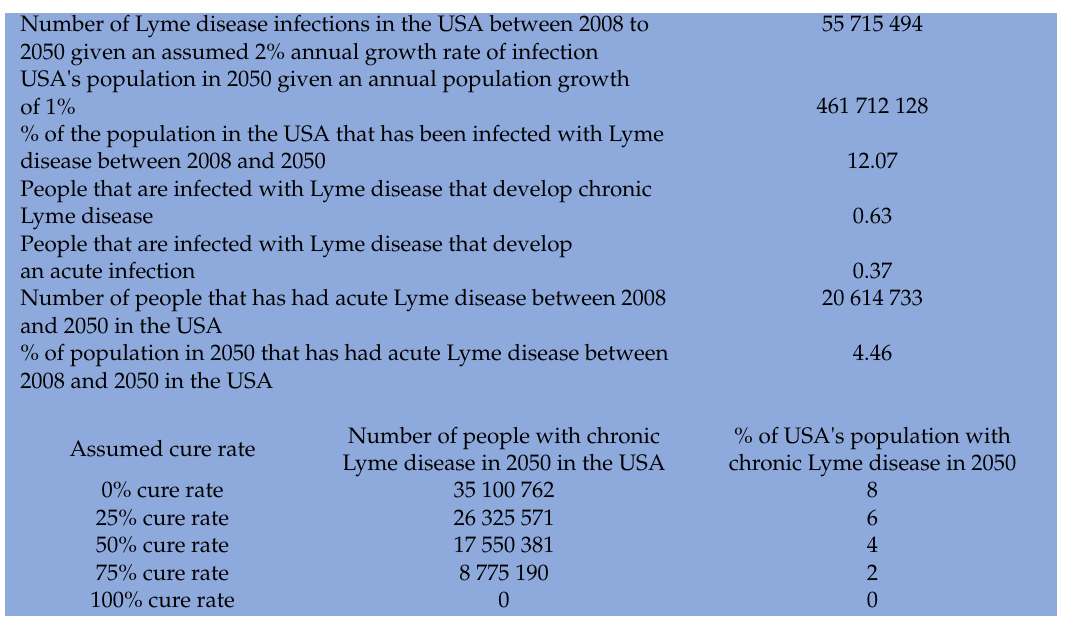
Table 8. Number of people with chronic Lyme disease in 2050 in the